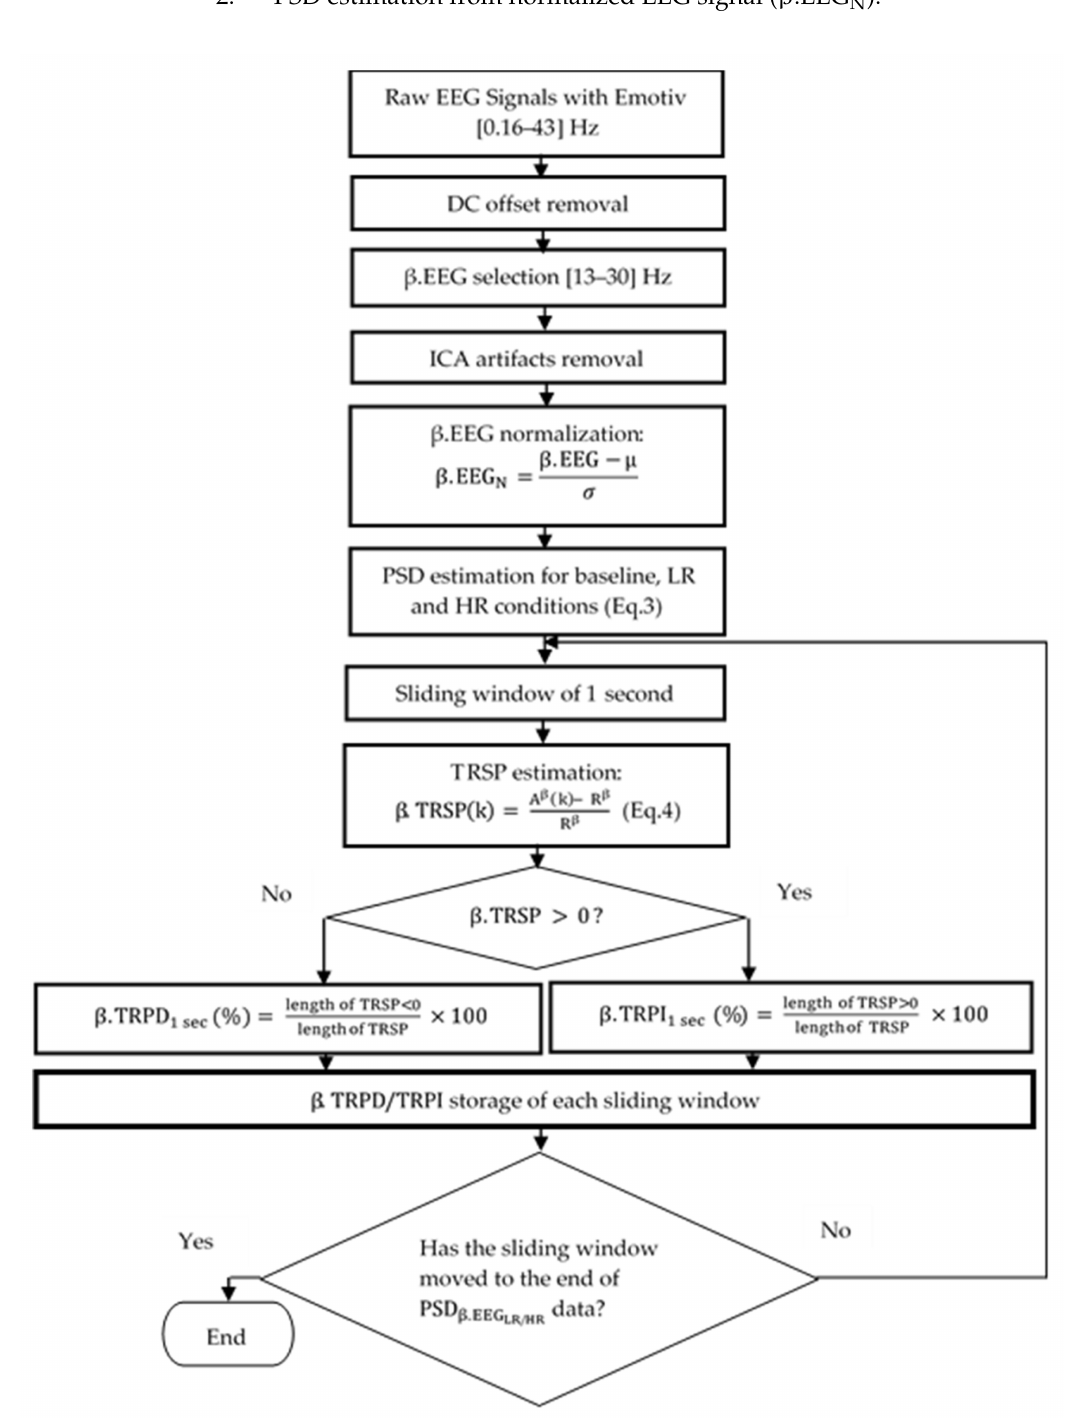
Figure 1. Flowchart diagram of offline electroencephalographic (EEG) preprocessing and Task-Related Power De- crease/Increase in beta frequency band ( β .TRPD/TRPI estimation in Matlab